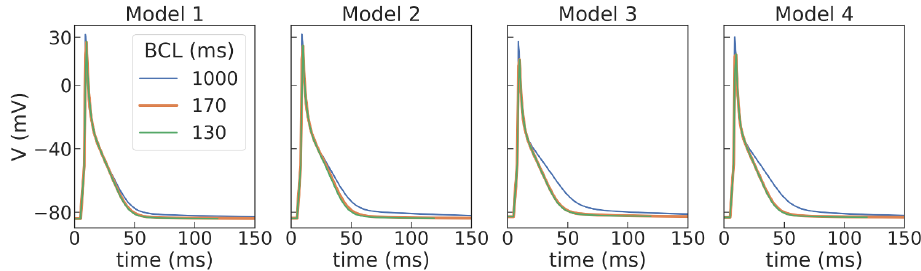
Figure 3. Action potential at BCLs of 1000, 170 and 130 ms in the updated Gattoni2016 cellular